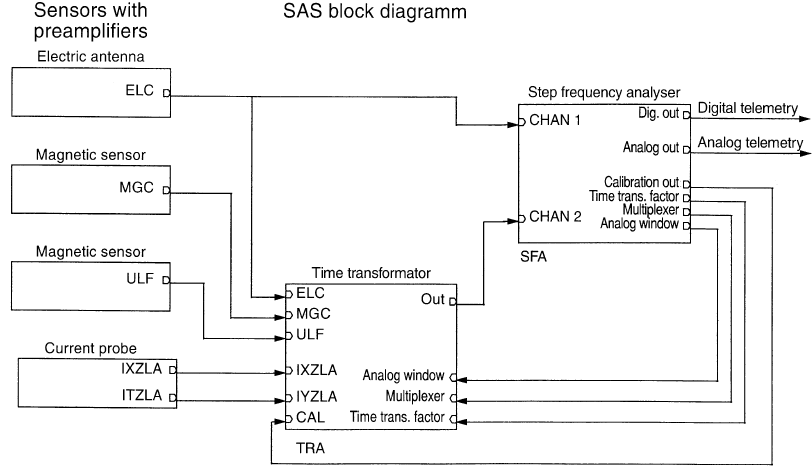
Fig. 1. Block scheme of the